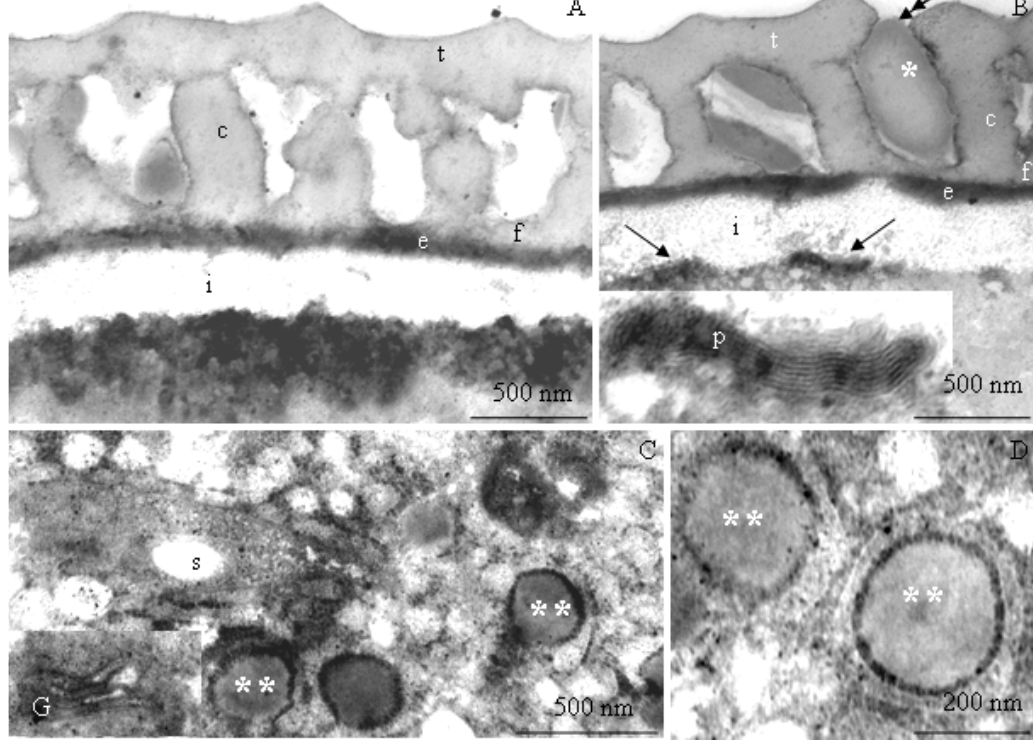
Figure 10. ( A – D ). Fragments of pollen grains in R. idaeus ‘Pokusa’: ( A , B )—tectum (t), perforation (double-headed arrow), pollenkitt (asterisk), columellae (c) and a foot layer (f), endoexine (e), intine (i) adjacent to numerous electron-dense structures (arrows) in the protoplast; ( C )—protoplast, visible plastoglobules (two asterisks), mitochondrion (m), starch grain (s) in the amyloplast, Golgi apparatus (G); ( D )—dense protoplast with plastoglobules (two asterisks), ( A – D ) - TEM. Endoexine. The endoexine layer in the pollen grains of the studied cultivars ranged from 76